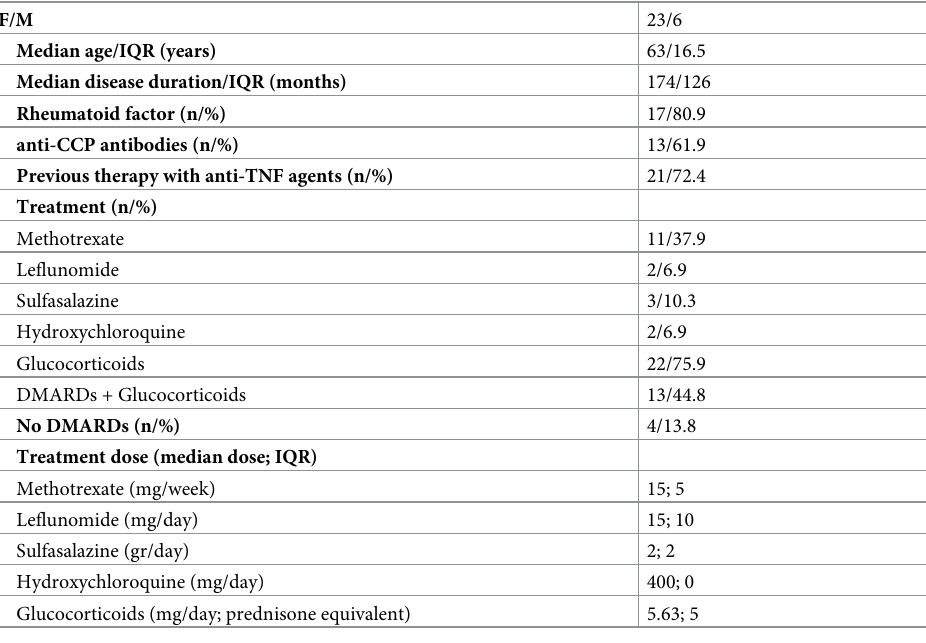
Table 1. Clinical and demographic features of the patients enrolled (n = 29).